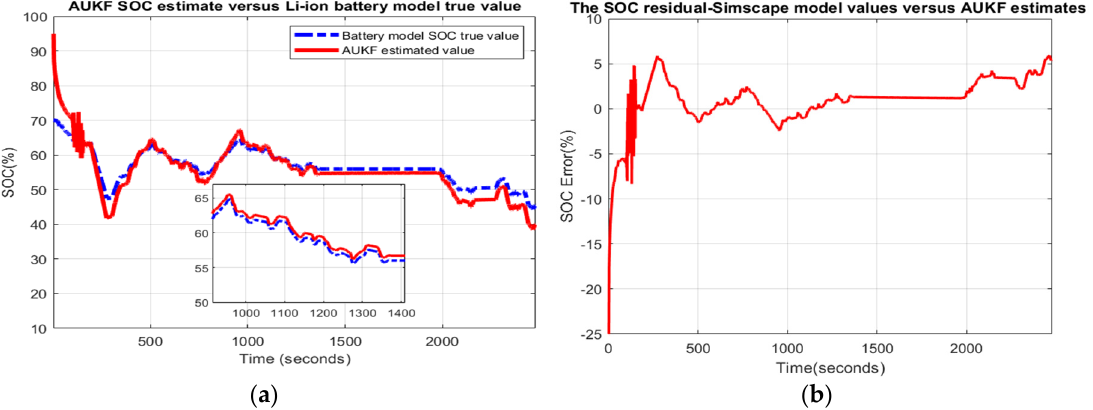
Figure 6. Robustness to simultaneous changes, SOCini = 1, Qnom = 4.2 Ah (ageing effects); ( a ) AUKF SOC value versus battery model true value; ( b ) SOC residual.